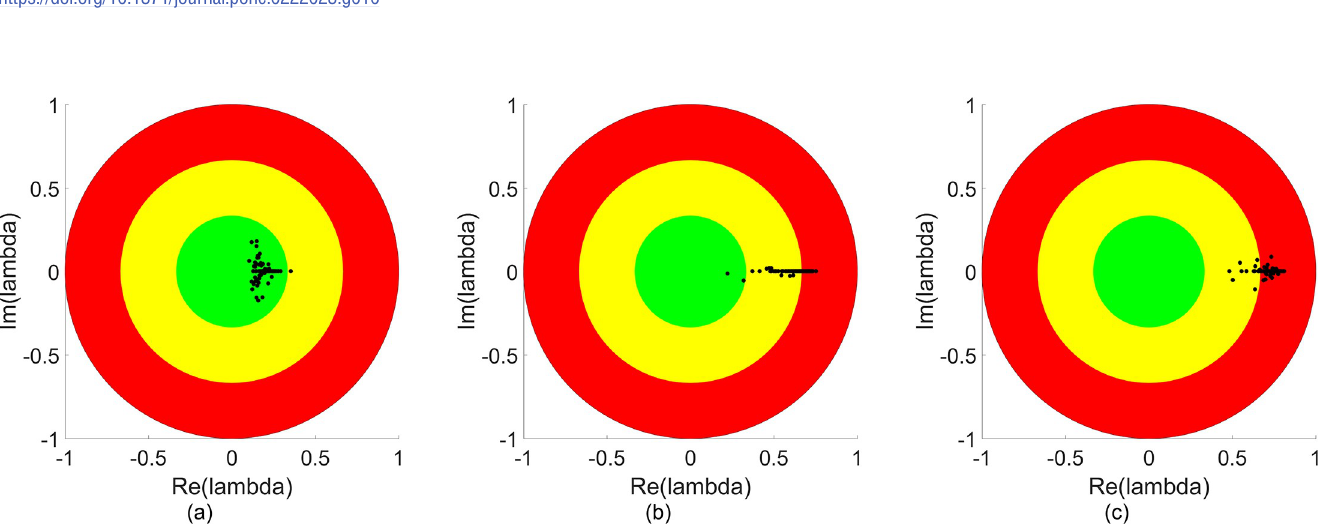
Fig 11. Schematic illustration of the possible use of the Koopman eigenvalue distribution as a diagnostic tool of the “health” of a dynamical system, where as noted in the text the specific radii of the colored regions shown here are arbitrary. For the case where the eigenvalue distribution is clustered in the green region (near the origin), the system is in a highly damped, fluctuation-dissipation regime and is thus likely “safe” and unlikely to exhibit extreme behavior. For the case where a significant number of eigenvalues are in the yellow region, the system damping is decreasing and the system may be approach a transition to more extreme behavior. When the eigenvalue distribution is heavily in the red region, the system is expected to be displaying fluctuations with limited or no damping and therefore extreme and potentially dangerous or damaging behavior.